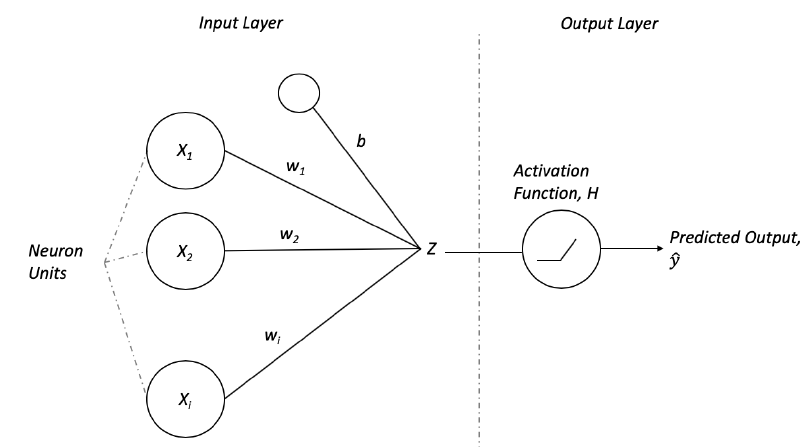
Figure 1. Basic components in a perceptron comprises of the input layer that can take in an arbitrary number of inputs, s , the weight, w that maps the inputs to the subsequent layer, a bias, b , activation function H to introduce non-linearity into the function and the output, Z